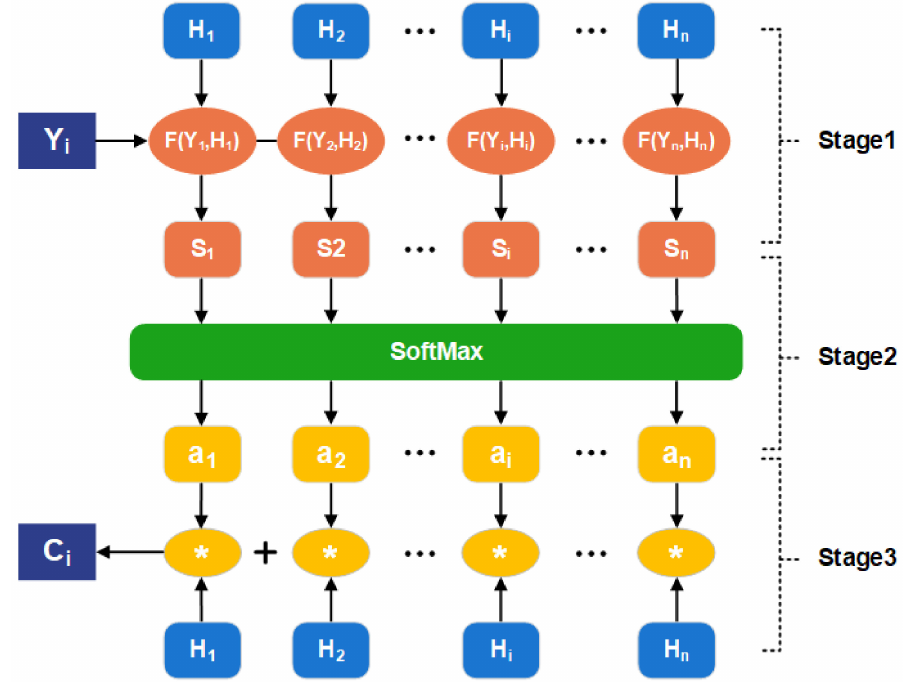
Figure 3. The structure of the attention mechanism (* represent